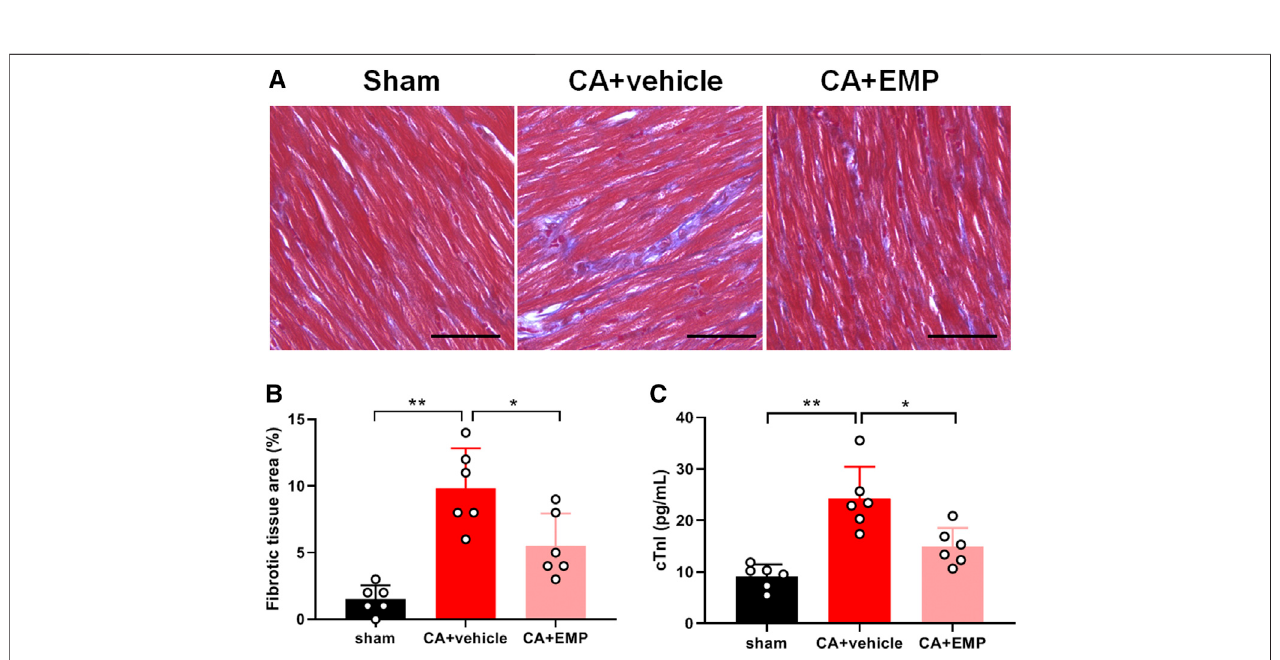
FIGURE 3 | Empagli fl ozin (EMP) decreased myocardial injury after cardiac arrest in rats. (A) Representative photographs of Masson staining of heart sections obtained 24 h after return of spontaneous circulation (ROSC). Masson staining showed that EMP decreased myocardial fi brosis (stained blue) after ROSC. Scale bar (cid:1) 50 μ m. (B) Quanti fi cation ofmyocardial fi brotic area from Masson stained section. (C) EMP decreased serum cardiac troponinI (cTnI) level at 24 h after ROSC. Dataare presented as mean ± SD, n (cid:1) 6, * p < 0.05, ** p < 0.01.